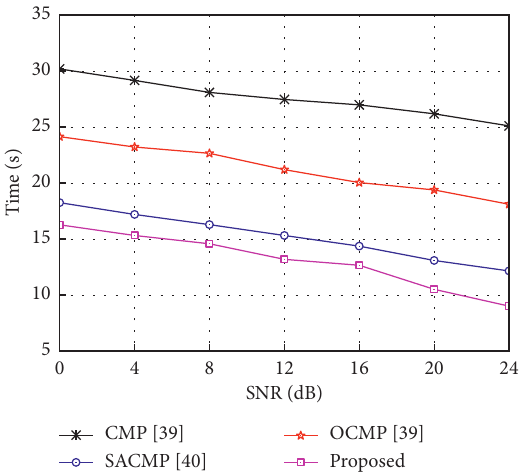
Figure 21: Computational time based on SNR of different